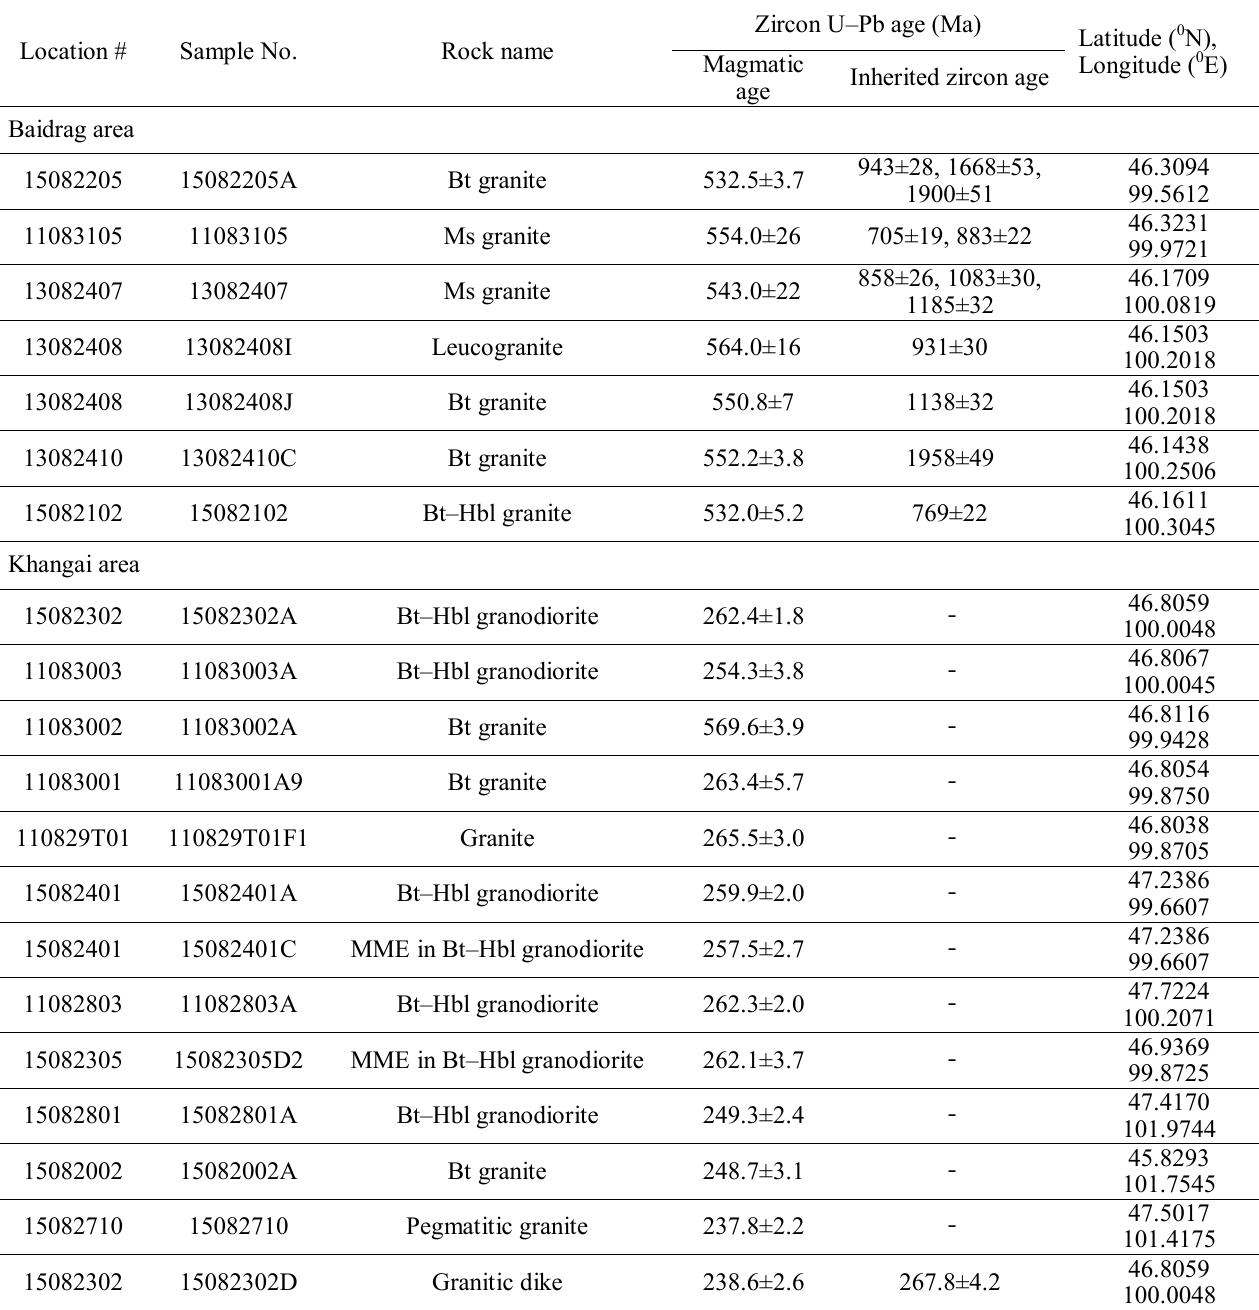
Table 1. Summary of LA–ICPMS U–Pb zircon